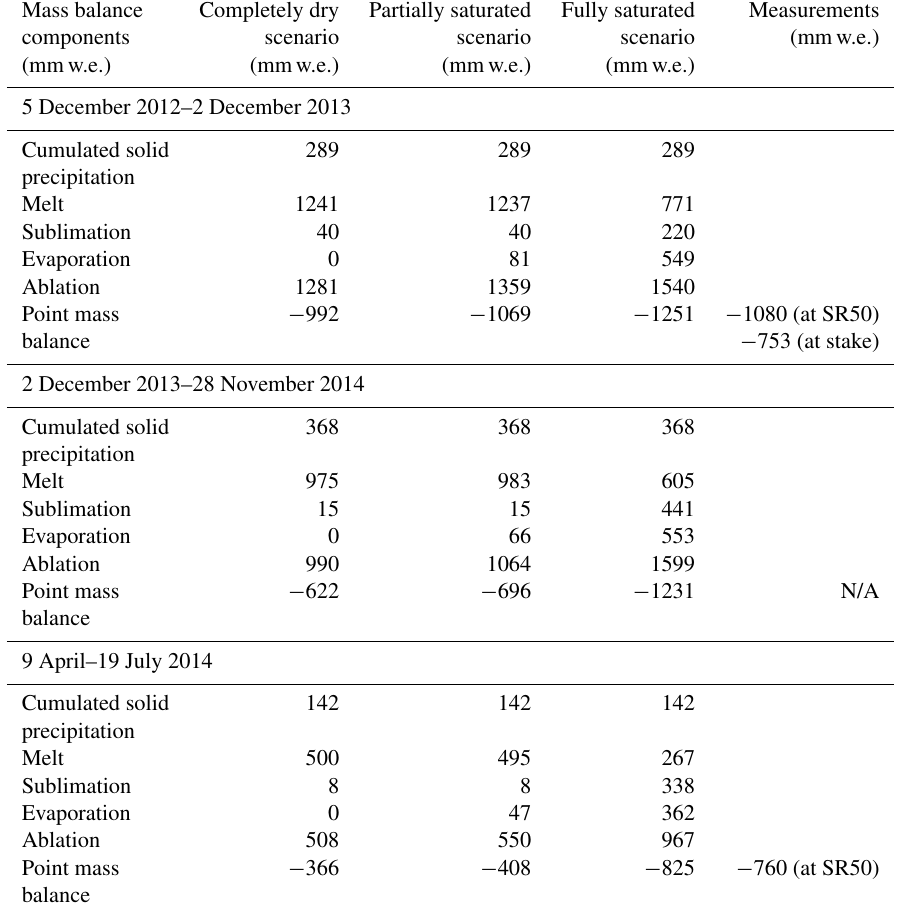
Table 3. Mass balance components of three model runs (dry debris, partially saturated debris, and fully saturated debris) compared with the available measured point mass balance from 5 December 2012 to 19 July 2014 (N/A indicates that data are not available). The observation- driven model behavior and output presented in previous figures is from what is termed the “partially saturated scenario” here. Note that runoff has not been taken into account for this